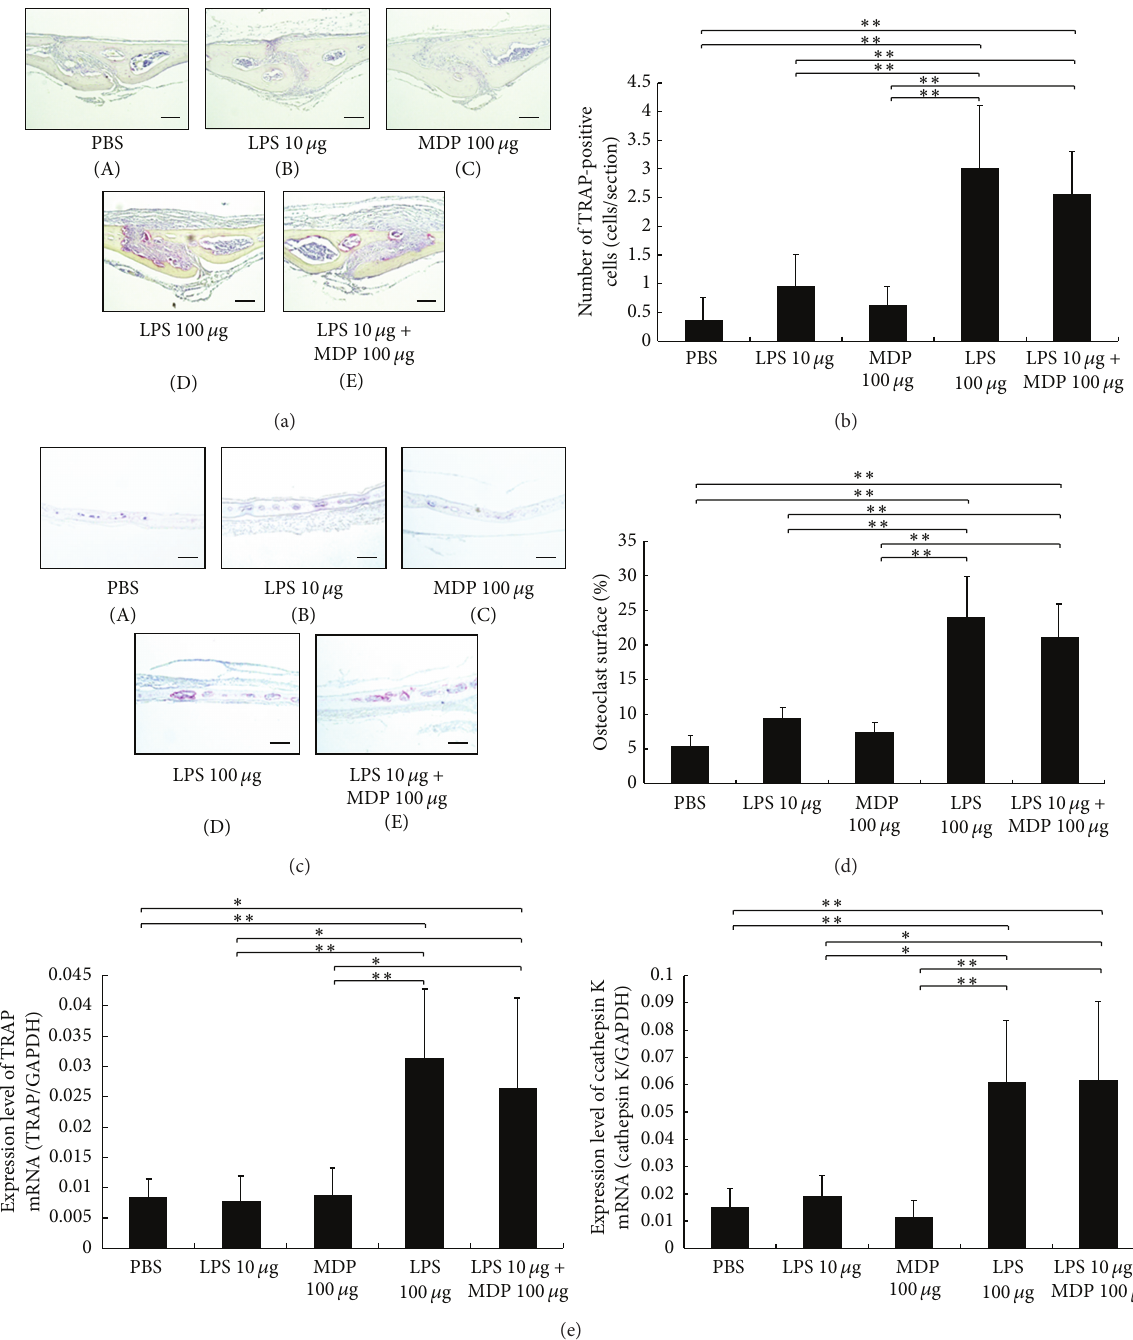
Figure 1: Effects of muramyl dipeptide (MDP) on lipopolysaccharide- (LPS-) induced osteoclast formation in vivo . (a) Histological sections of sutures of calvariae were obtained from mice after 5 days of daily supracalvarial injections of one of the following: PBS (A), 10 𝜇 g/day LPS (B), 100 𝜇 g/day MDP (C), 100 𝜇 g/day LPS (D), or 10 𝜇 g/day LPS + 100 𝜇 g/day MDP (E). Sections were stained with tartrate-resistant acid phosphatase (TRAP) staining and counterstained with hematoxylin. Cells that stained red are considered to be TRAP-positive. Scale bars = 50 𝜇 m. (b) The number of TRAP-positive cells with three or more nuclei in the calvariae ( 𝑛 = 4 ; ∗∗ 𝑃 < 0.01 ). (c) Histological sections of calvariae were obtained from mice after 5 days of daily supracalvarial injections of one of the following: PBS (A), 10 𝜇 g/day LPS (B), 100 𝜇 g/day MDP (C), 100 𝜇 g/day LPS (D), or 10 𝜇 g/day LPS + 100 𝜇 g/day MDP (E). Scale bars = 100 𝜇 m. (d) The percentage of bone/marrow interface covered by osteoclasts was histomorphometrically determined in specimens ( 𝑛 = 4 ; ∗∗ 𝑃 < 0.01 ). (e) TRAP and cathepsin K mRNA levels in mouse calvariae detected using real-time RT-PCR. Total RNA from mouse calvariae was isolated after 5 days of daily supracalvarial injections of PBS, LPS (10 𝜇 g/day), MDP (100 𝜇 g/day), LPS (100 𝜇 g/day), or LPS (10 𝜇 g/day) + MDP (100 𝜇 g/day). mRNA levels for TRAP and cathepsin K were normalized to GAPDH. Results are expressed as the mean ± SD ( 𝑛 = 4 ; ∗∗ 𝑃 < 0.01 ; ∗ 𝑃 < 0.05 ). Differences were determined using Scheffe’s 𝐹